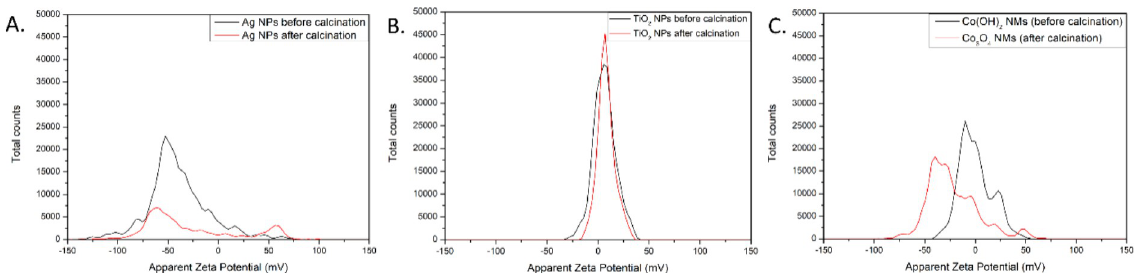
Fig 6. Zeta potential measurements of the prepared nanomaterials. (A) Ag NPs before and after calcination, (B) TiO2 NPs before and after calcination, (C) Co(OH)2 NMs and Co3O4 NMs.